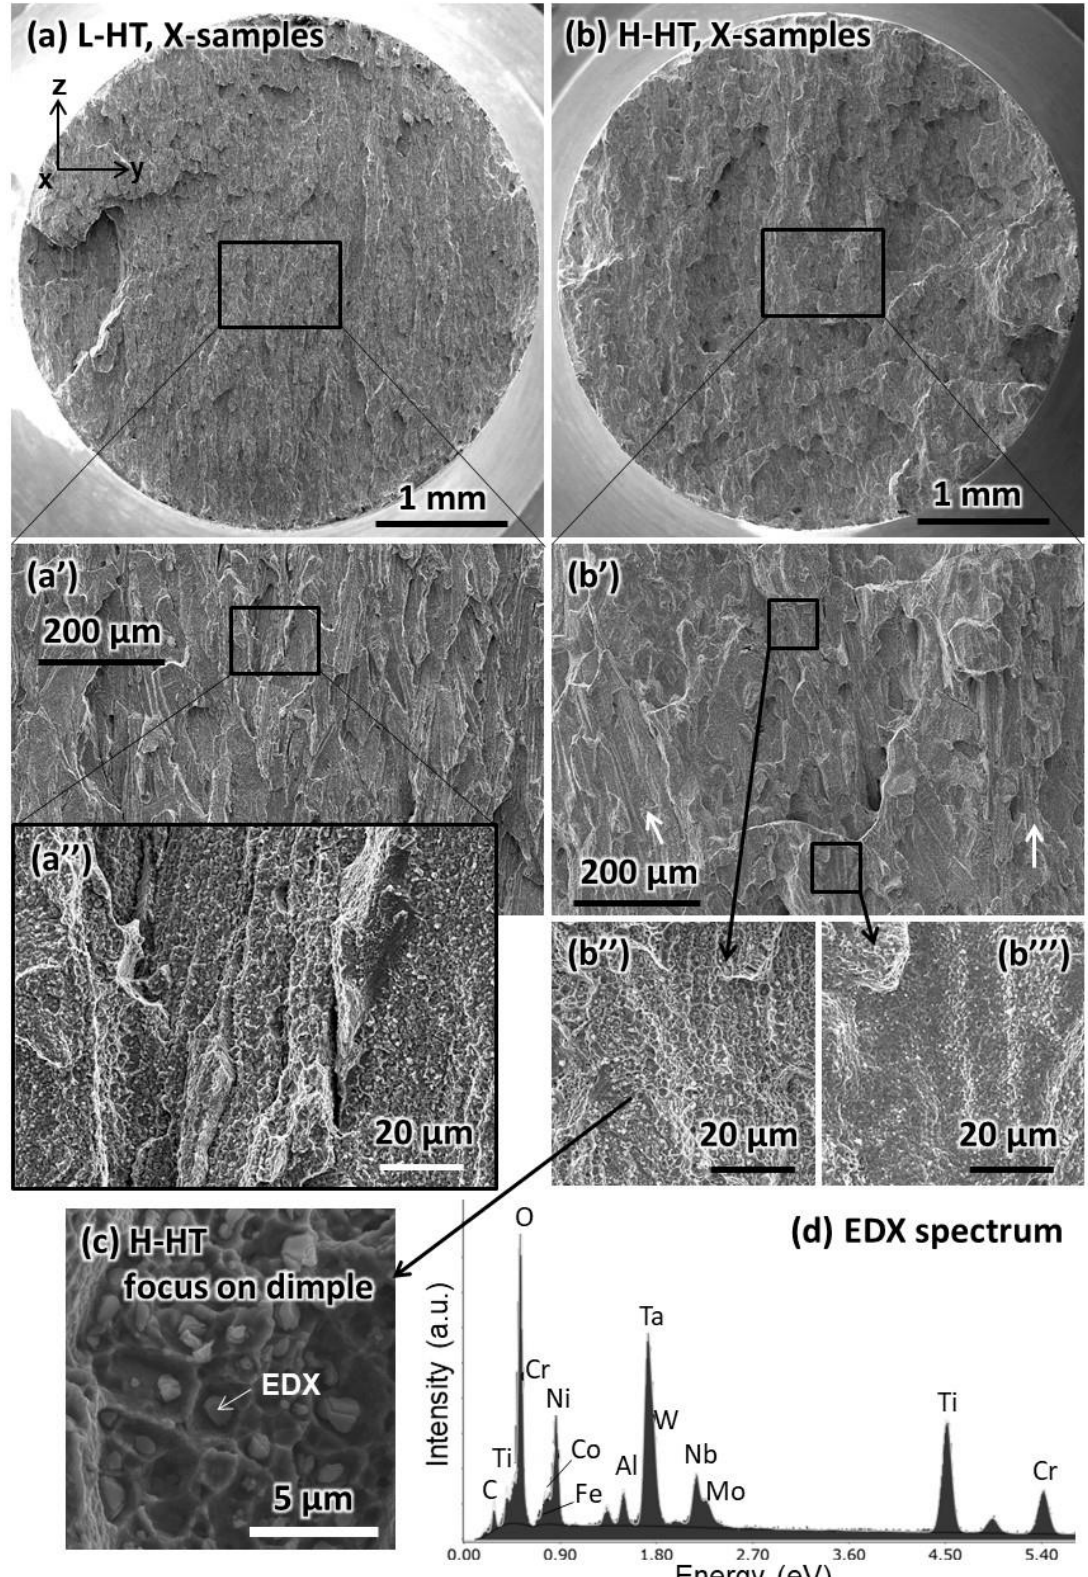
Figure 6. Fracture surface of ( a – a” ) L-HT-ed and ( b – b”’ , c ) H-HT-ed materials with various magnifications. ( d ) EDX spectrum measured at the point indicated in ( c ).